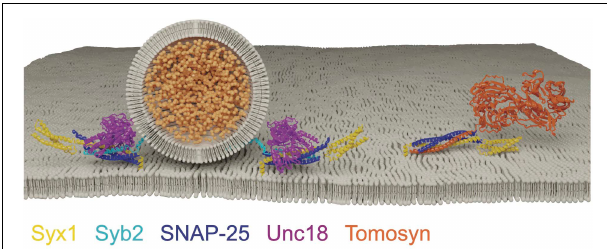
FIGURE 6 | Tomosyn forms a decoy SNARE complex with Syx1 and SNAP-25 in an Unc18 and Syb2 independent manner. Adapted from Pobbati et al. (2004); Hattendorf et al.